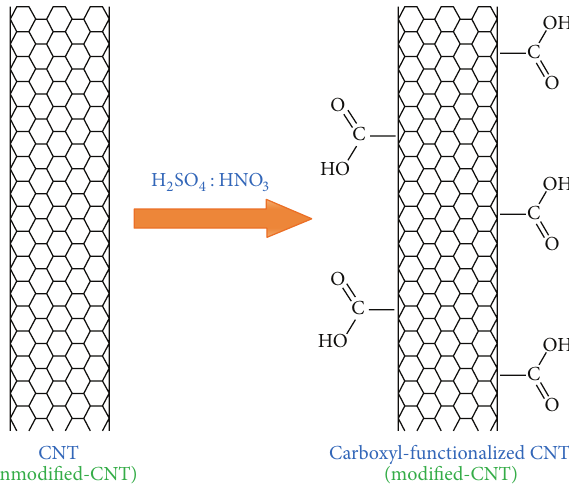
Figure 1: The formation of carboxyl groups on the acid-treated carbon nanotube